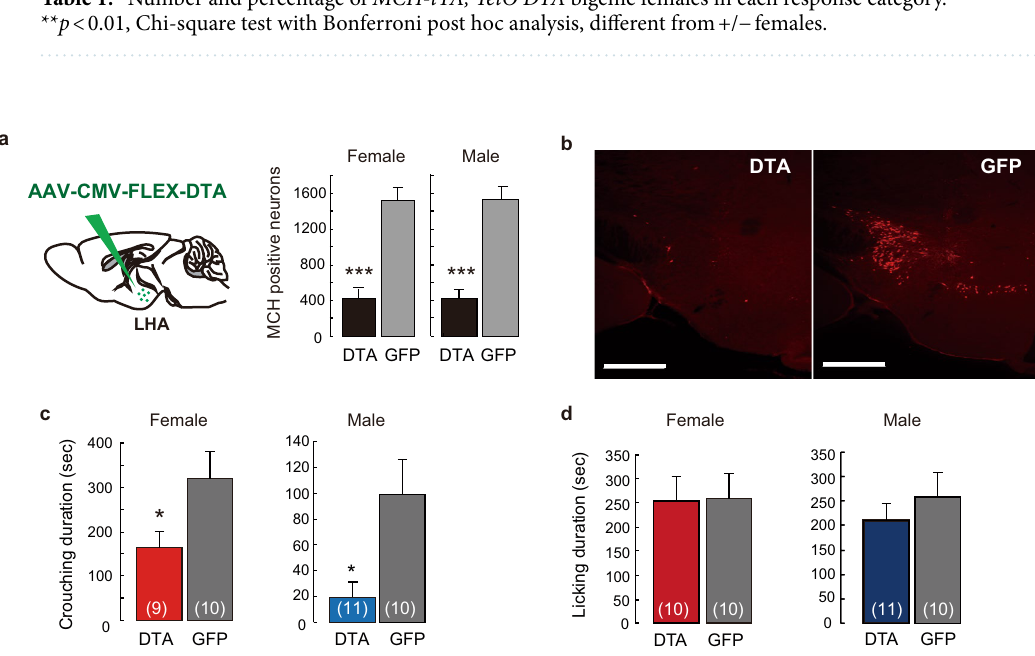
Figure 2. Cre-dependent ablation of MCH-producing neurons effects of parenting nursing behaviour. ( a ) Cre-MCH dependent expression with AAV-CMV-FLEX-DTA injection affected the number of MCH positive neurons specifically in the LHA in both sexes. ( b ) An example of ablation by AAV-DTA injection. Scale bars, 500 μm. ( c , d ) Effect of AAV-DTA injections on the duration of crouching ( c ) and licking ( d ). Mean ± S.E.M. t-test, * p < 0.05, *** p <